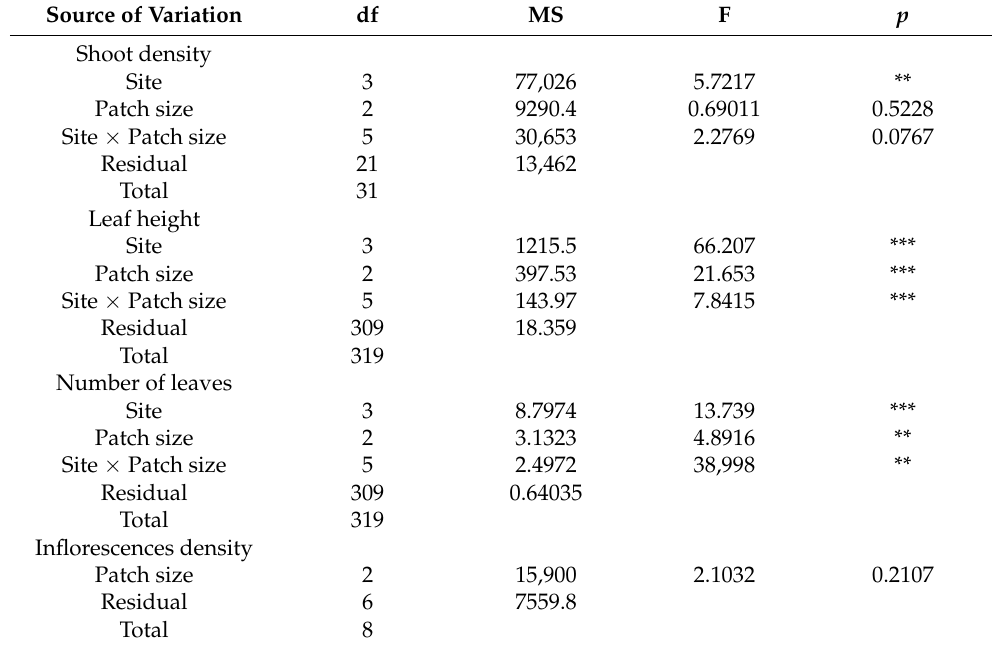
Table 1. Results of two-way PERMANOVA test for differences in shoot density, maximum leaf height, and number of leaves of Posidonia oceanica amongst sites and patch size. Results of one-way PERMANOVA test for differences in inflorescence density of P. oceanica meadows of Calahonda SAC amongst patch sizes. Significant differences are indicated by: ** p < 0.01; *** p < 0.001. Source of Variation df MS F